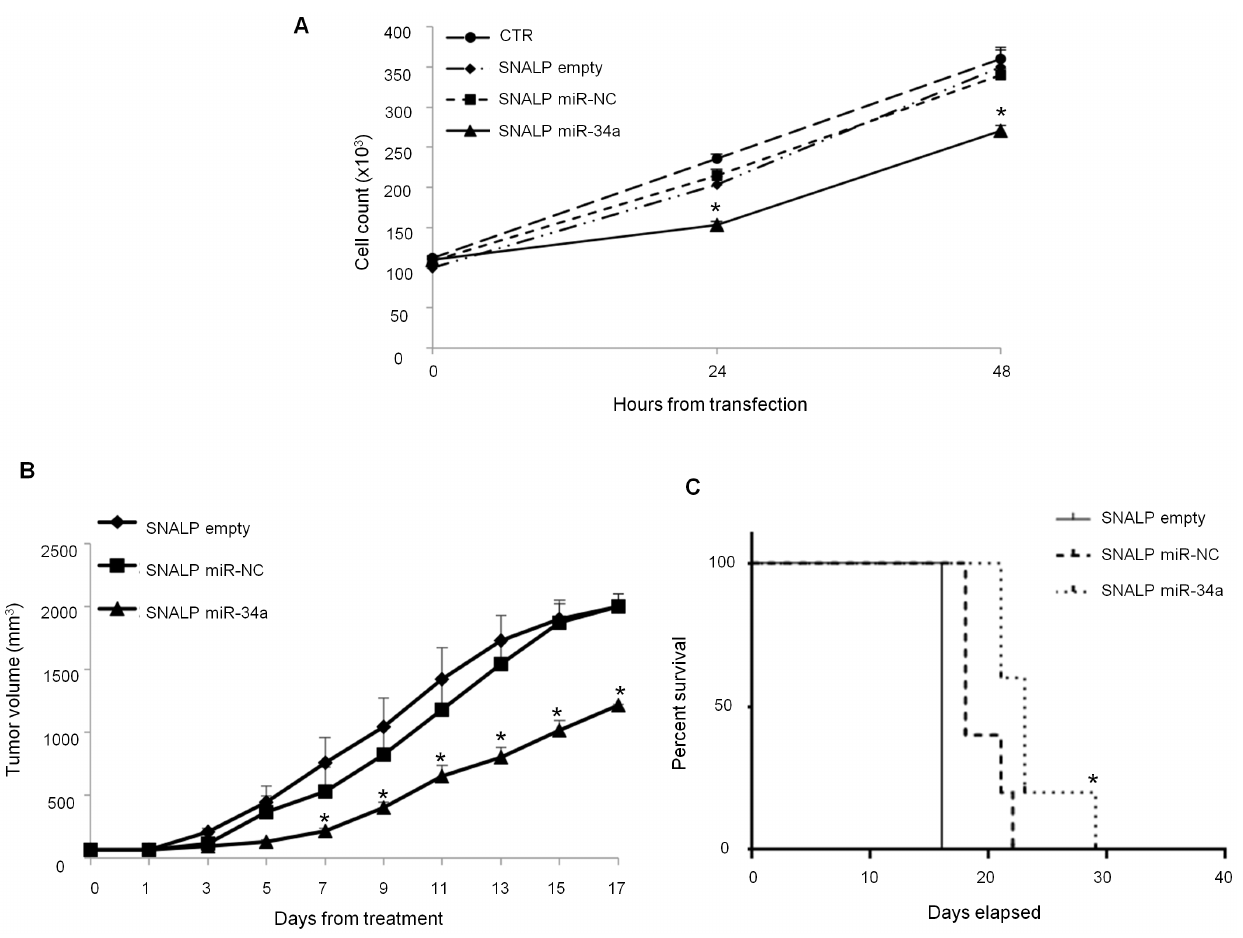
Figure 3. SNALPs formulated miR-34a has anti-proliferative activity against MM invitro and invivo . A) Trypan blue exclusion assay of SKMM-1 cells treated with SNALP-encapsulated miR-34a or scramble oligonucleotides as control (NC). Analysis was performed by microscope Burker chamber counts and trypan blue exclusion assay. Averaged values of three independent experiments are plotted including 6 SD. P-values calculated by Student’s t test, two-tailed, at 24 and 48 hours after transfection, are respectively: 0.001 and 0.02 versus SNALP empty or 0.0099 and 0.01 versus SNALP miR-NC. B) Mice carrying palpable subcutaneous SKMM-1 tumor xenografts were treated by intravenous tail vein injections with 20 m g for each treatment of miR-34a encapsulated into SNALPs. As control SNALPs incapsulating scramble miR-NC or empty were used. Caliper measurement of tumors were taken every 2 days from the day of the enrollment. Averaged tumor volumes of 4 mice per group are reported 6 SD. (*) indicate significant P -values ( P , 0.05). D) Survival curves (Kaplan-Meier) of treated mice show prolongation of survival after SNALP formulated miR-34a treatment compared to controls (log-rank test, P =0.0047 and 0.002 SNALP miR-34a vs empty and miR-NC, respectively). Survival was evaluated from the first day of treatment until death or